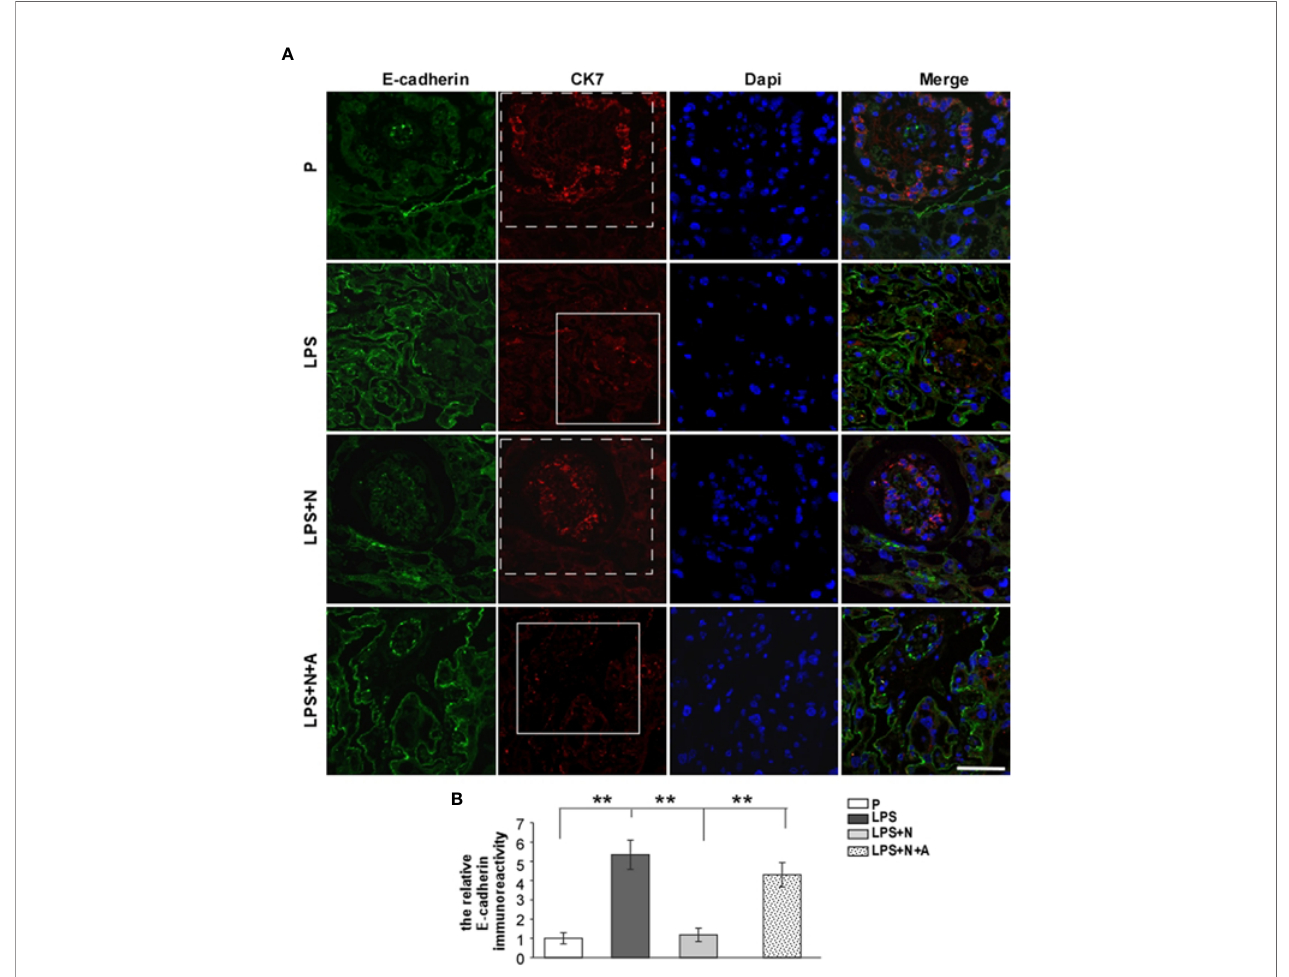
FIGURE 6 | The higher E-cadherin expression in placentas from PE-like mice which indicated invasive abnormity of the trophoblast was inhibited by nicotine. Representative immuno fl uorescent images (A) and quantitative analysis (B) showed changes in the relative immunoreactivity of placental E-cadherin in all groups. The dotted frame represented the trophoblast layer stained by CK7 in the P and LPS+N group; the solid frame represented the degenerated trophoblast layer weakly stained by CK7. Scale bar=50 m m. **P <